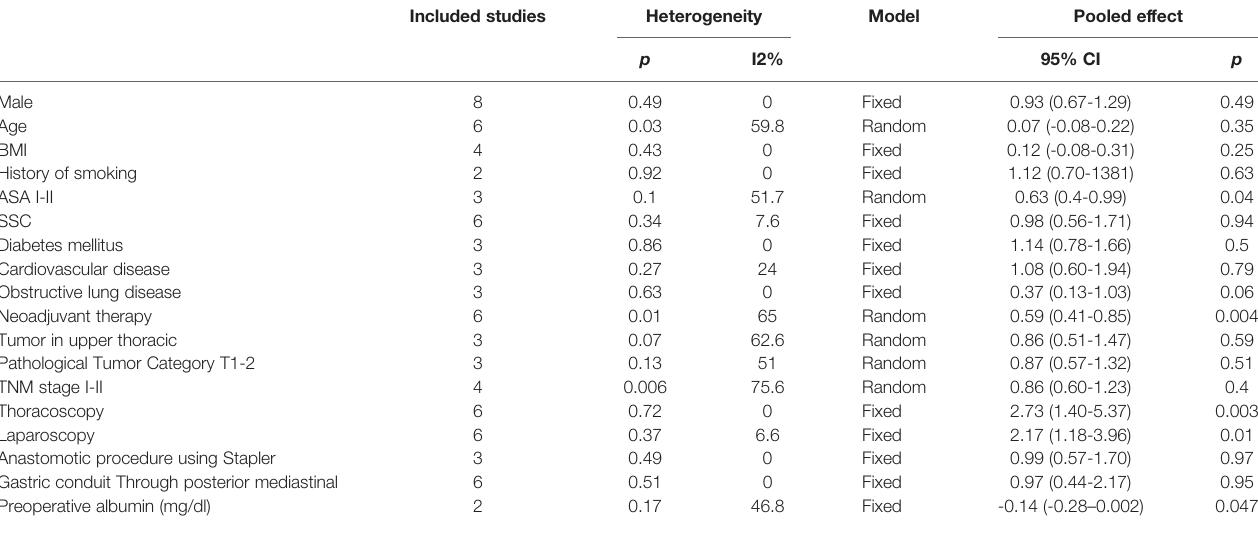
TABLE 1 | Baseline characteristics of included